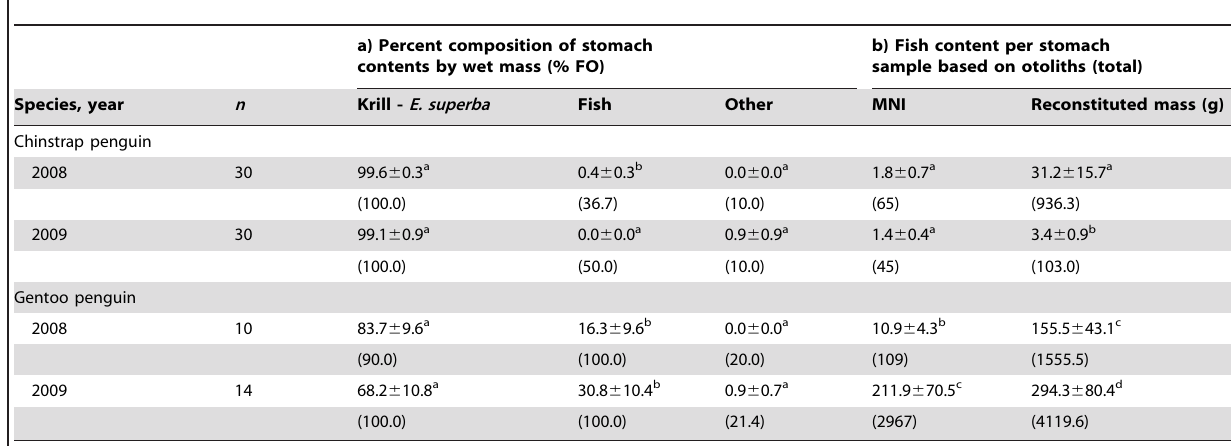
Table 1. The composition and occurrence of common prey groups and the minimum number of individual fish and reconstituted fish mass recovered from penguin stomach